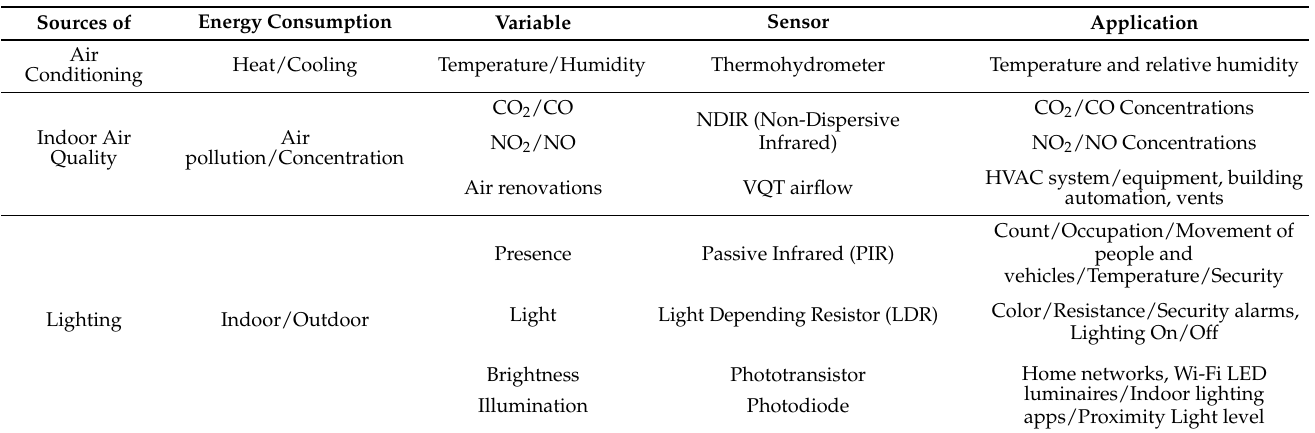
Table 2. Sources of energy consumption in